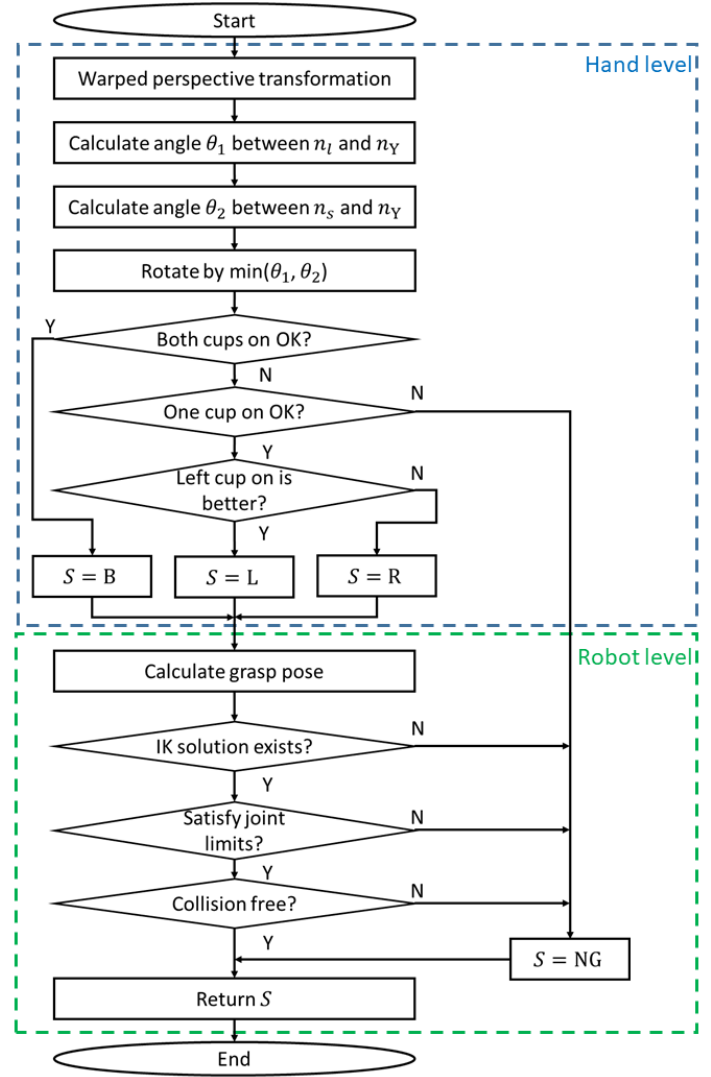
Figure 5. Class-labeling algorithm. The blue dashed line indicates steps for hand-level class labeling. The green dashed line indicates steps for robot-level class labeling. S is a grasp pattern, namely, a class label. L, R, B, and non graspable (NG) indicate left cup on, right cup on, both cups on, and non-graspable, respectively. IK indicates an inverse kinematics